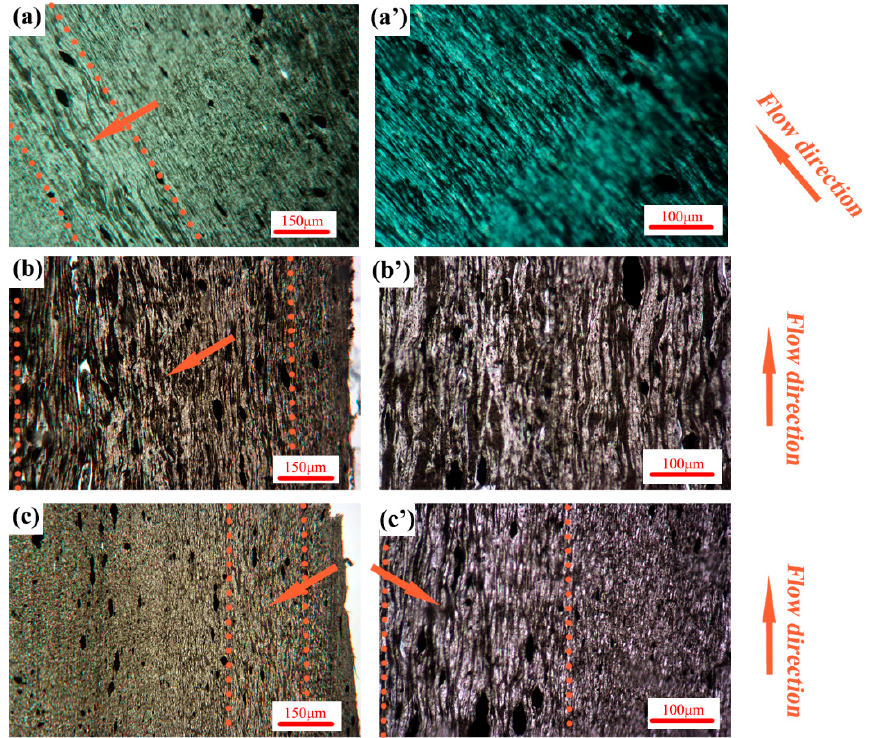
Figure 8. POM images of A2(C) ( a , a ’); A2(M) ( b , b ’); and A2(P) ( c , c ’).